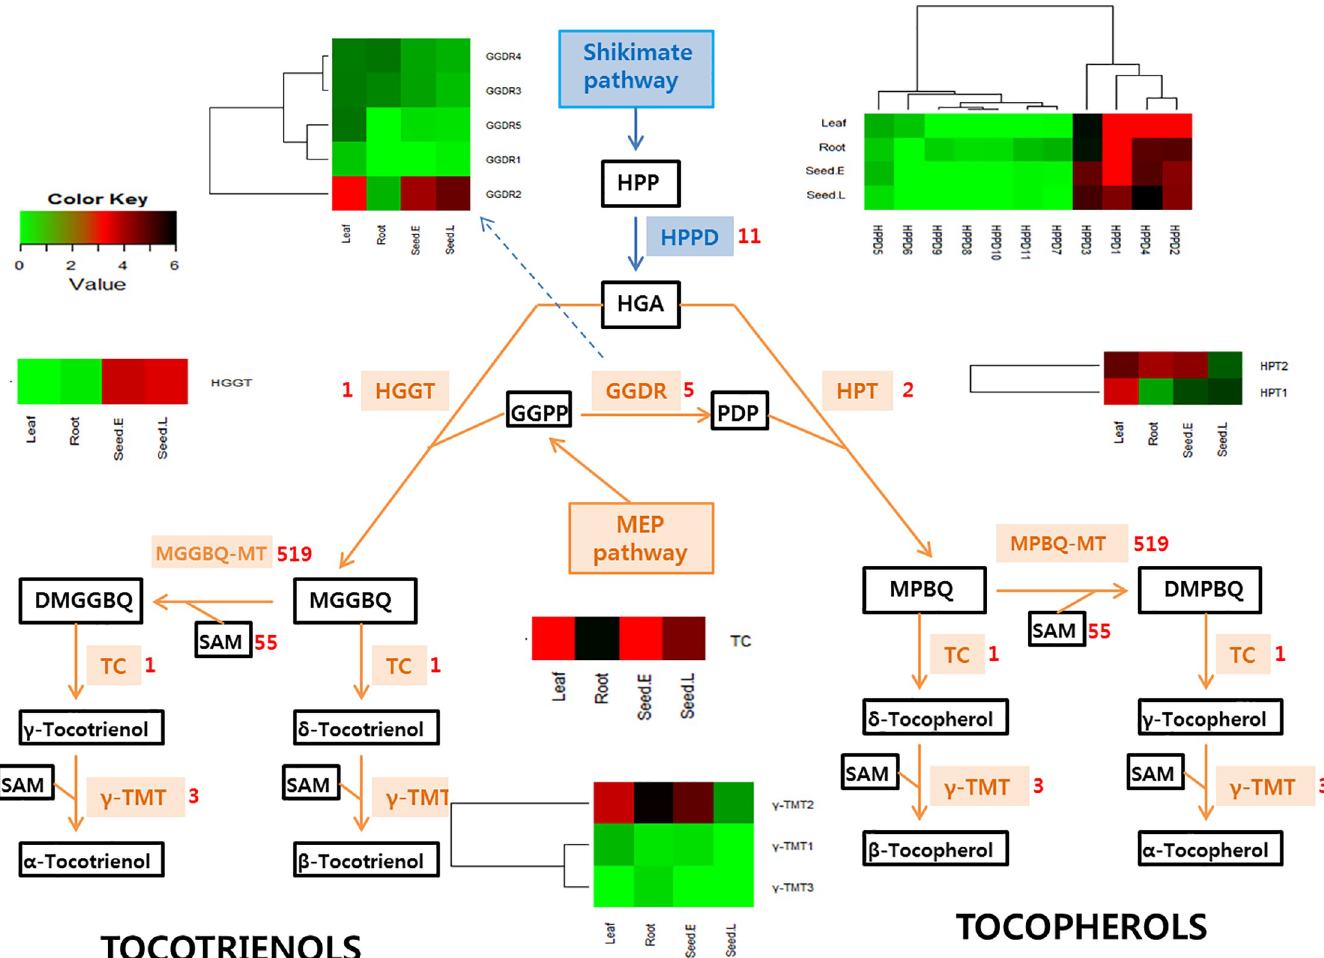
Fig 5. Genes predicted to be involved in the vitamin E synthesis pathway. Vitamin E synthesis is largely divided into two pathways that are regulated by homogentisate geranylgeranyl transferase (HGGT) and homogentisate phytyltransferase (HPT). The 9 differentially expressed enzymes in vitamin E synthesis are ρ - hydroxy phenyl pyruvic acid dioxygenase (HPPD), 2-methyl-6-phytyl benzoquinone methyltransferase (MPBQ-MT), 2-methyl-6-geranylgeranyl-plastoquinol methyltransferase (MGGBQ-MT), tocopherol cyclase (TC), γ -tocopherol methyltransferase ( γ -TMT), geranylgeranyl diphosphate reductase (GGDR), homogentisate geranylgeranyl transferase (HGGT), homogentisate phytyltransferase (HPT), and S-adenosylmethionine (SAM). Heat map analysis shows the differential tissue-specific expression of 22 genes associated with the vitamin E pathways. The color bar indicates the value of expression in a sample, based on the color key at the upper left corner. Black indicates upregulation and green,